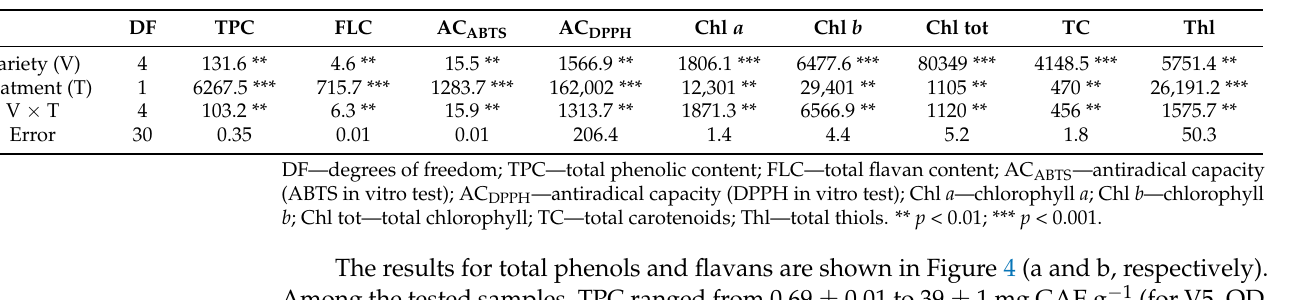
Table 2. Factorial analysis based on phytochemical traits of leaf samples from different hop varieties subjected to different drying